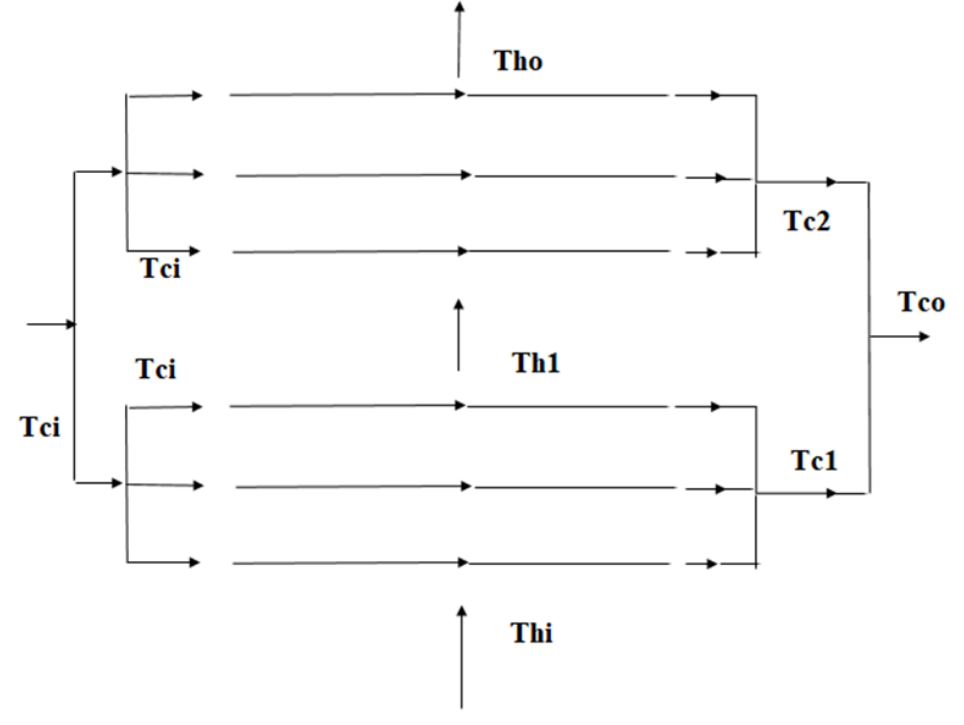
Figure 1. Three tube, two row, pure cross flow heat exchanger.